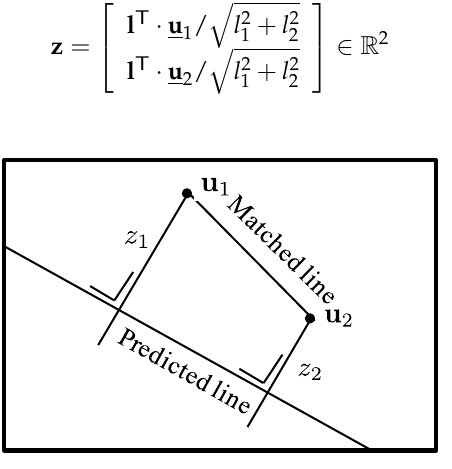
354 Fig. 11 Plücker line Fig. 11 Plücker line observation update. Direct Fig. 11 Plücker line observation update. Direct measurement of the two signed observation update. Direct measurement of the two signed Fig. 11 Plücker line orthogonal distances from the measurement of the two signed orthogonal distances from the observation update. Direct detected endpoints to the orthogonal distances from the detected endpoints to the measurement of the two signed expected (or predicted) line detected endpoints to the expected (or predicted) line orthogonal distances from the expected (or predicted) line detected endpoints to the expected (or predicted) line